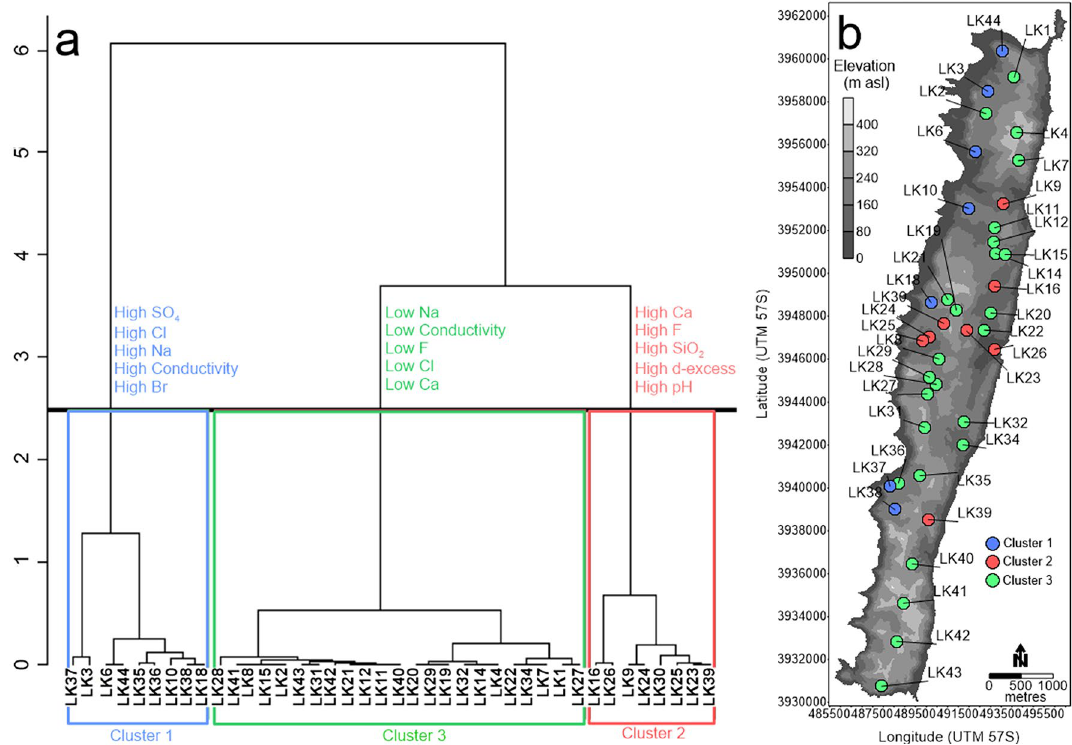
Figure 3. ( a ) Hierarchical cluster analysis of lake water chemistry variables on Macquarie Island, showing three lake clusters and the five most significant variables associated with each cluster (Table S4). ( b ) Lakes coloured by cluster membership superimposed on a layer of the islands elevational